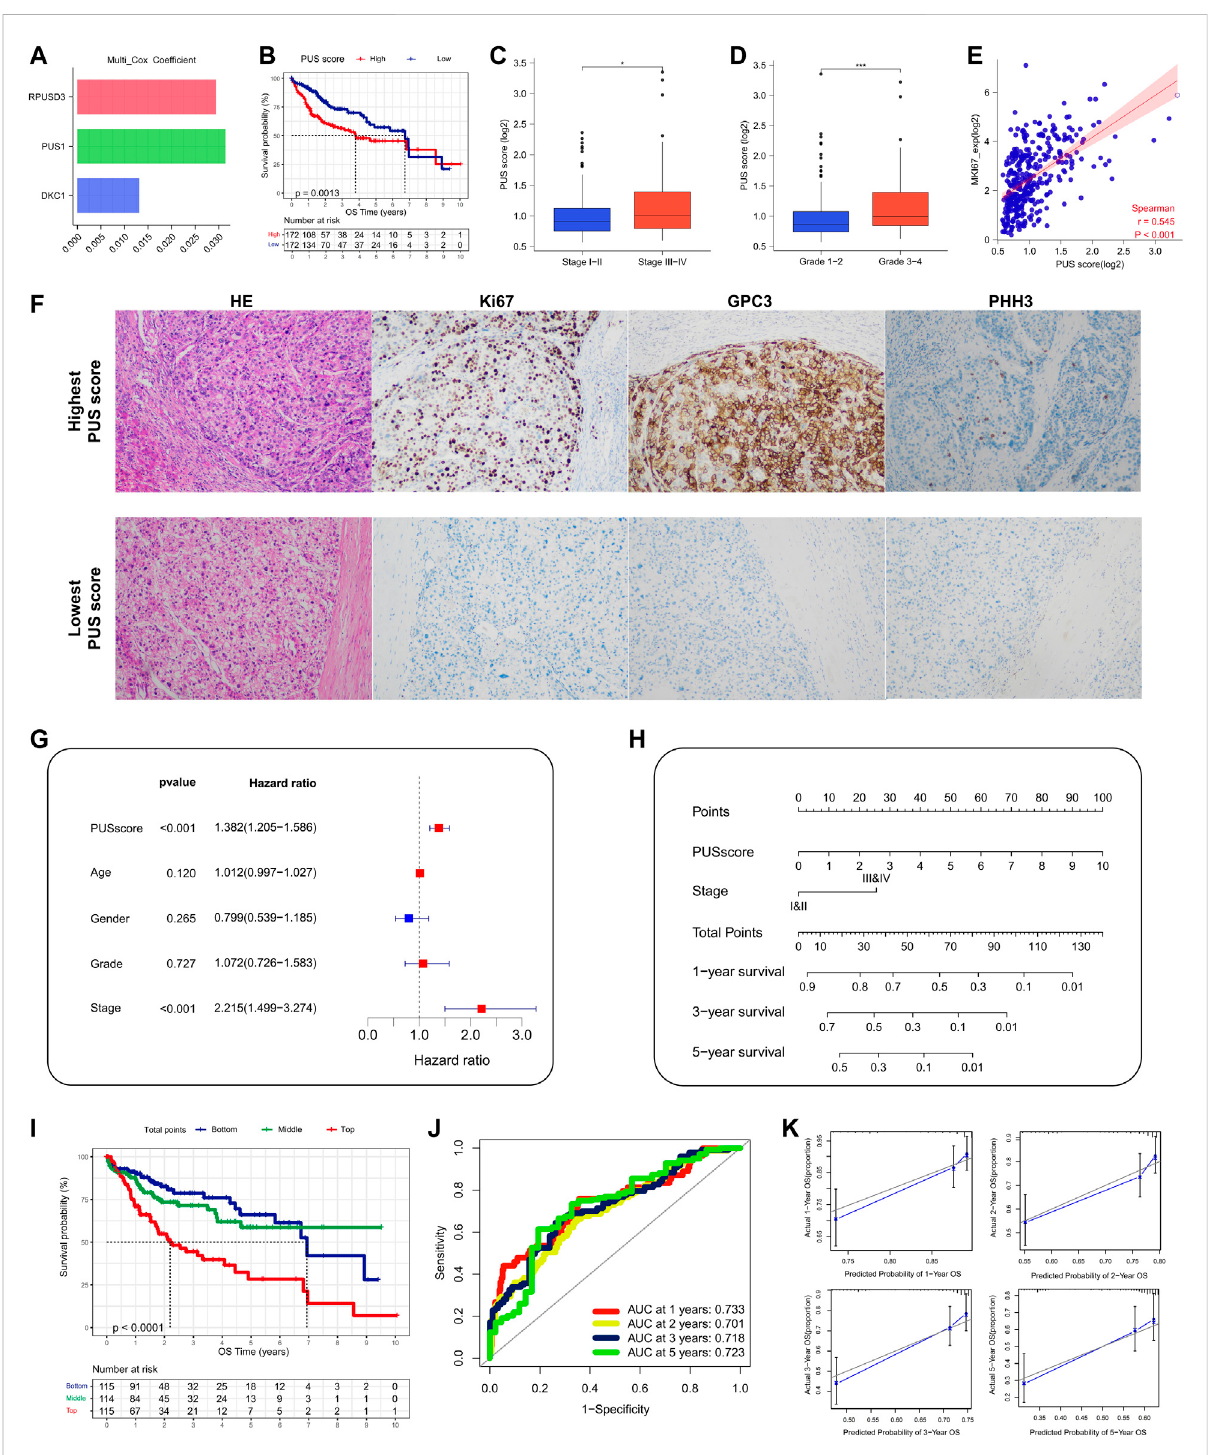
FIGURE 4 Construction and validation of a PUS- based nomogram. (A) The coef fi cients of three optimal PUSs ; (B) K-M analysis for OS of HCC patients strati fi edbyPUSscore; (C – D) Association ofPUSscorewithtumorstage (C) andtumorgrade (D) ; (E) Correlation ofPUSscorewith MKI67 expression; (F) Representative HE staining and immunohistochemical results of HCC tissues with different levels of PUSscore; (G) Multivariate Cox analysis of PUSscore and clinical factors; (H) Development of a nomogram based on PUSscore and tumor stage; (I) K-M analysis for OS of HCC patients strati fi ed by nomogram points; (J) The time-dependent ROC curves of the nomogram; (K) The calibration curves for the